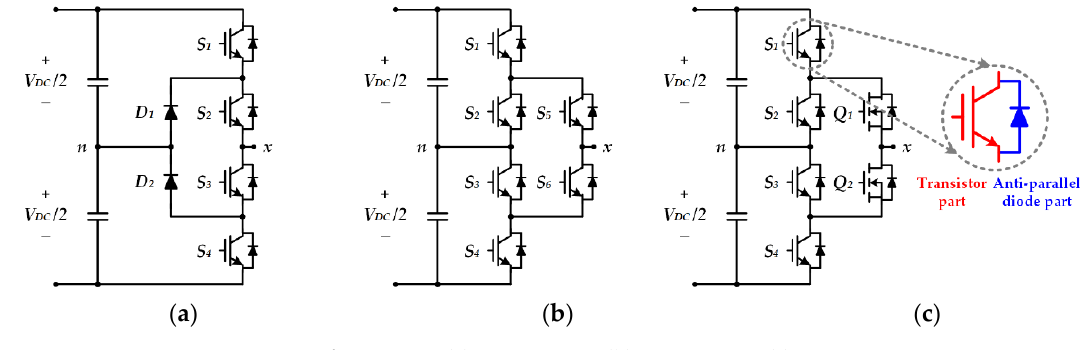
Figure 2. Types of 3-L VSCs: ( a ) DNPC-type; ( b ) ANPC-type; ( c ) HANPC-type.